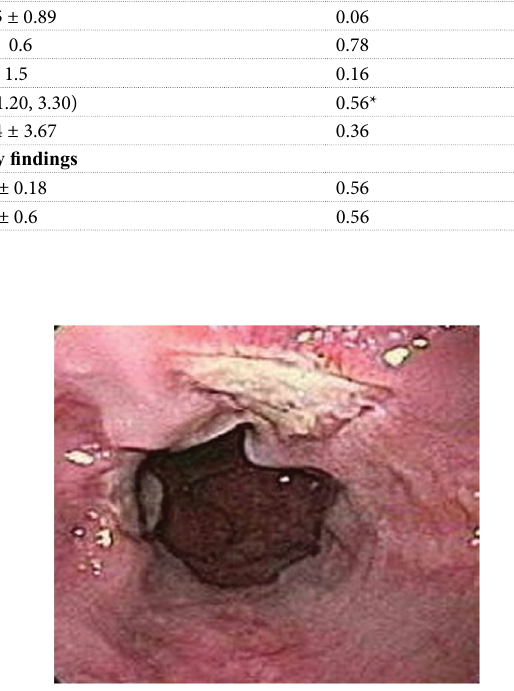
Figure 2: Representative band ulcer in the study